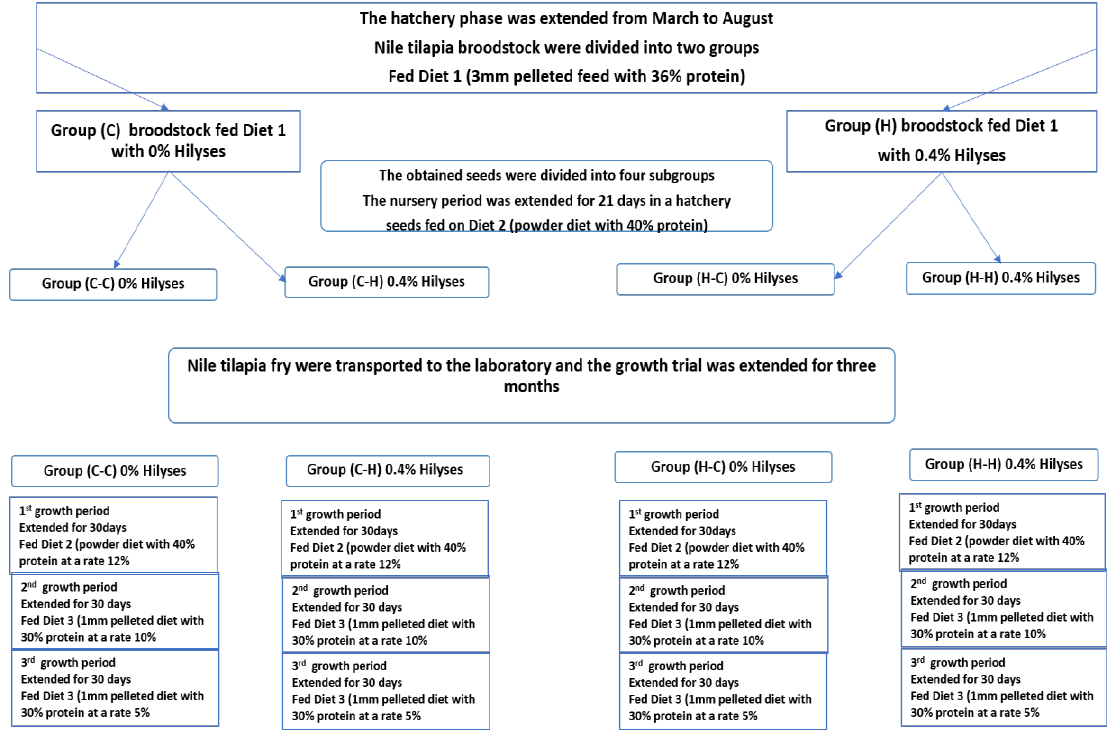
Figure 1. Summary of experimental